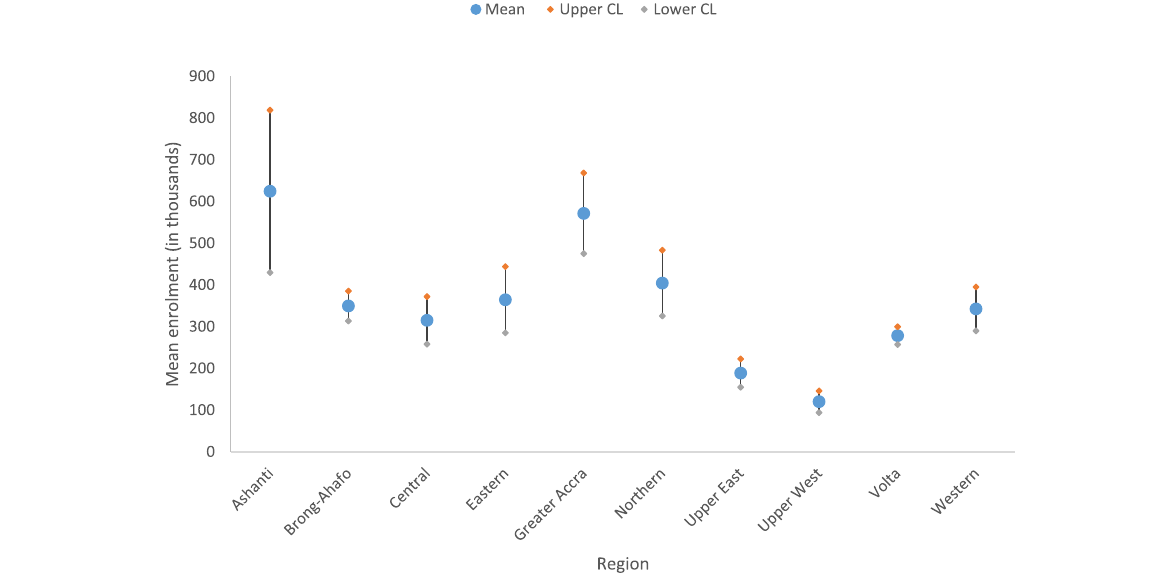
Fig. 3 Point and interval estimates (95% CI) for new enrolment by region, 2010 –